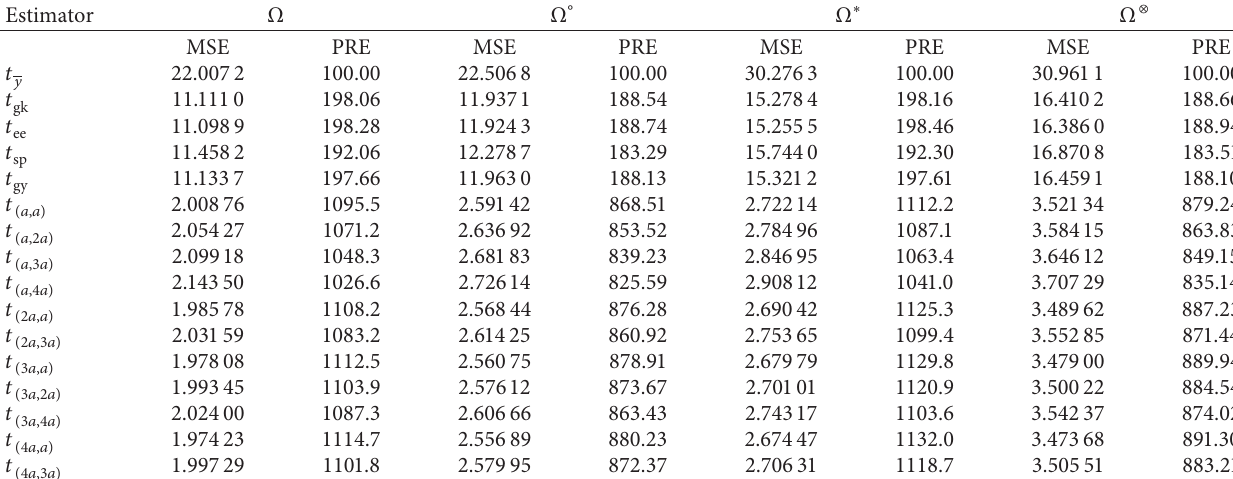
Table 1: MSE and PRE of the estimators for n � 40.